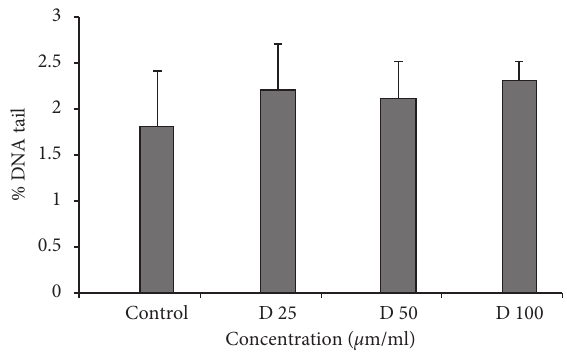
Figure 1: DNA damage of human lymphocytes treated with fraction. Human lymphocytes were incubated for 15min at 4 ° C with different concentrations of fractions (25, 50, and 100 μ g/ml).